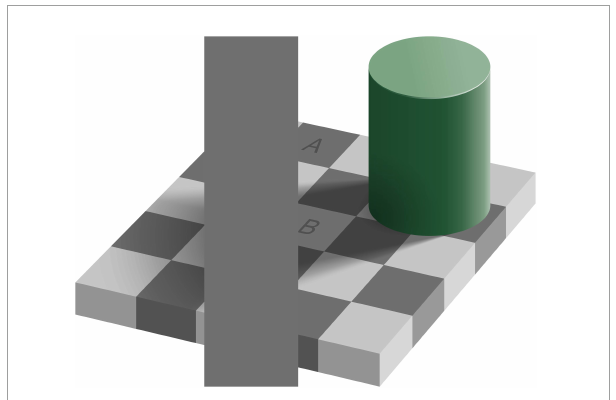
FIGURE1 Inconsistent perception of brightness (original by Edward